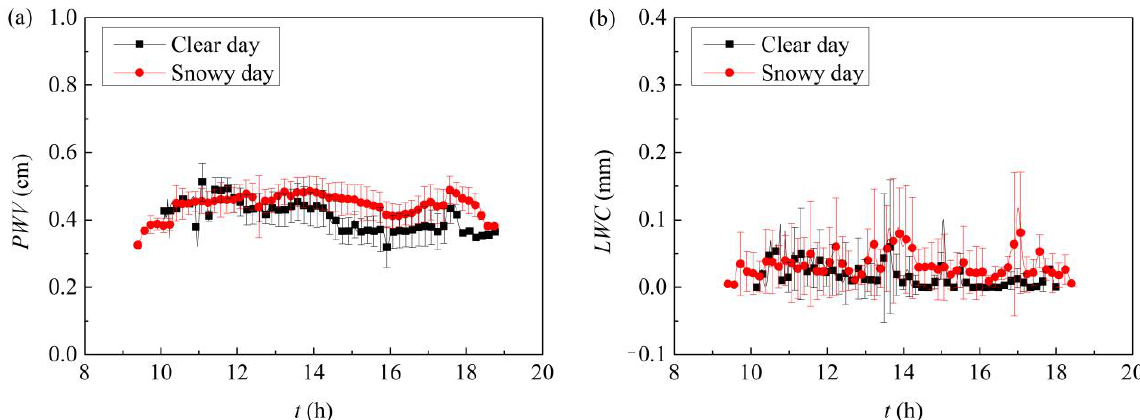
Figure 8. Statistical characteristics of vapour density and liquid water content (from 8:00 to 20:00 monsoon) under different weather conditions. ( a ) Precipitable water vapour ( PWV ), ( b ) integrated liquid water content ( LWC ). The t (h) is expressed in UTC+8.